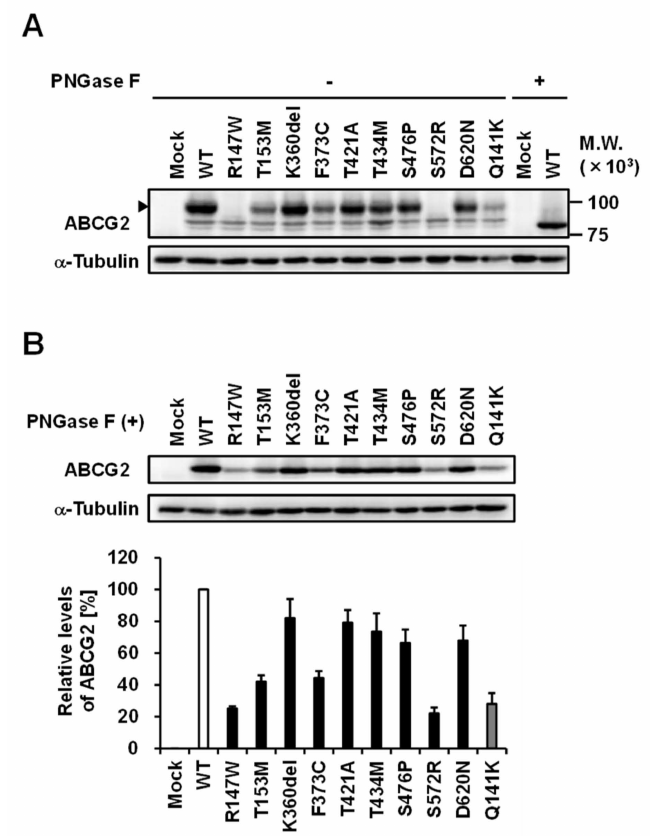
Figure 3. E ff ects of each mutation on the maturation status and protein levels of ABCG2 in transiently transfected 293A cells. ( A ) Immunoblot detection of ABCG2 wild-type (WT) and its variants in the whole cell lysate samples that were prepared 48 h after the transfection. Arrowhead, matured ABCG2 as a glycoprotein; α -Tubulin, a loading control. ( B ) Relative protein levels of ABCG2 WT and its variants. The signal intensity ratio (ABCG2 / α -tubulin) of the immunoreactive bands was determined and normalized to that in ABCG2 WT-expressing cells. Data are expressed as the mean ± SD. n =